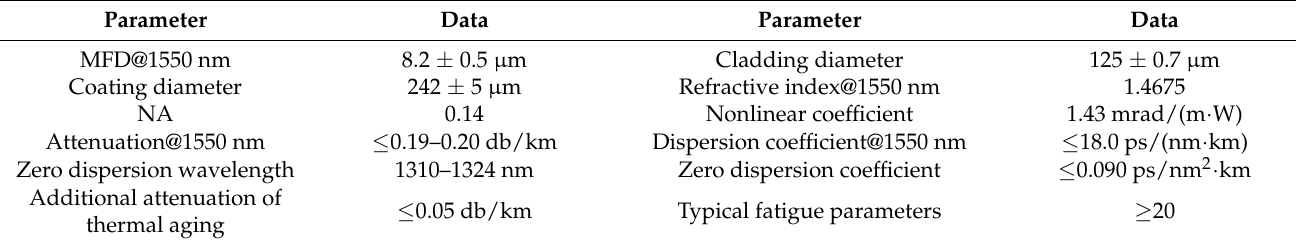
Figure 1. Schematic of the passively Q-switched and mode-locked Er 3+ -doped fiber laser. Table 1. The typical parameters of SMF-28e single-mode fiber.